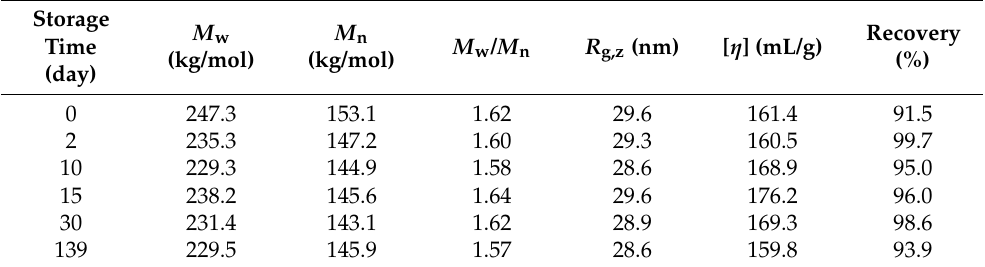
Figure 3. ( a ) RI and ( b ) LS at 90° signals as a function of elution volume, ( c ) molecular weight distribution curves, and ( d ) variation of M w and M n with storage time for PAA stored at − 12 °C. The label − 12 °C-0 d represents the original PAA solution, while − 12 °C-2 d represents that it was stored at − 12 °C for 2 days. Table 3. Molecular parameters of (6FDA-DMB) PAA in a concentrated solution stored at − 12 °C for different times, measured by GPC-RI-MALLS-VIS.